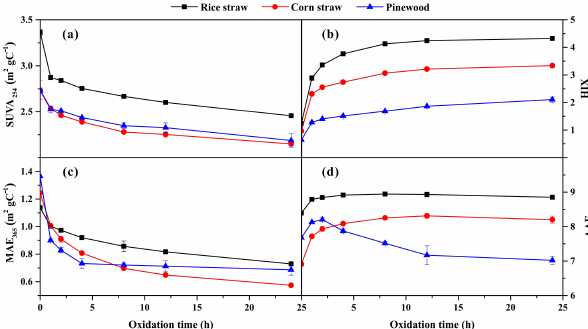
Figure 3. Dynamic variations of (a) SUVA 254 , (b) HIX, (c) MAE 365 , and (d) AAE of RS, CS, and PW smoke water-soluble BrC during the ozone aging